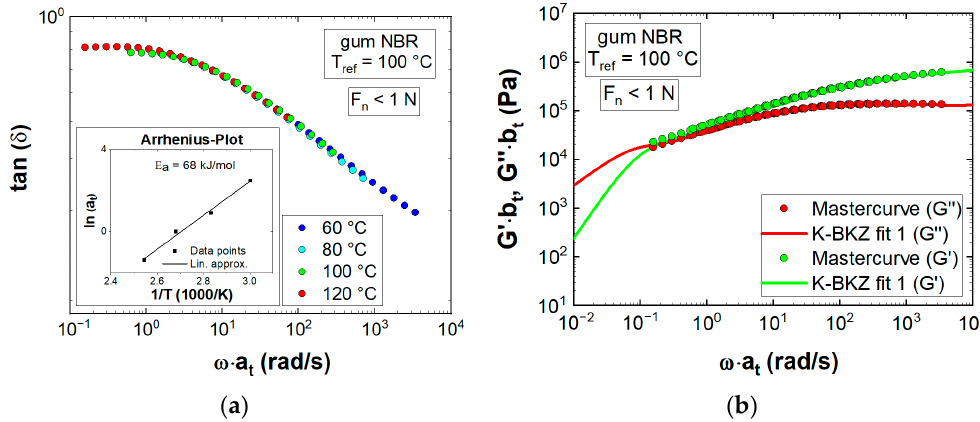
Figure 4. ( a ) Time-temperature superposition of the dissipation factor ( tanδ ) and corresponding Arrhenius plot; ( b ) K-BKZ model predictions of storage G’ and loss G” moduli compared to experimental data at the reference temperature T ref ; K-BKZ fit 1 represents LVE data measured at a normal force (F n ) < 1 N.